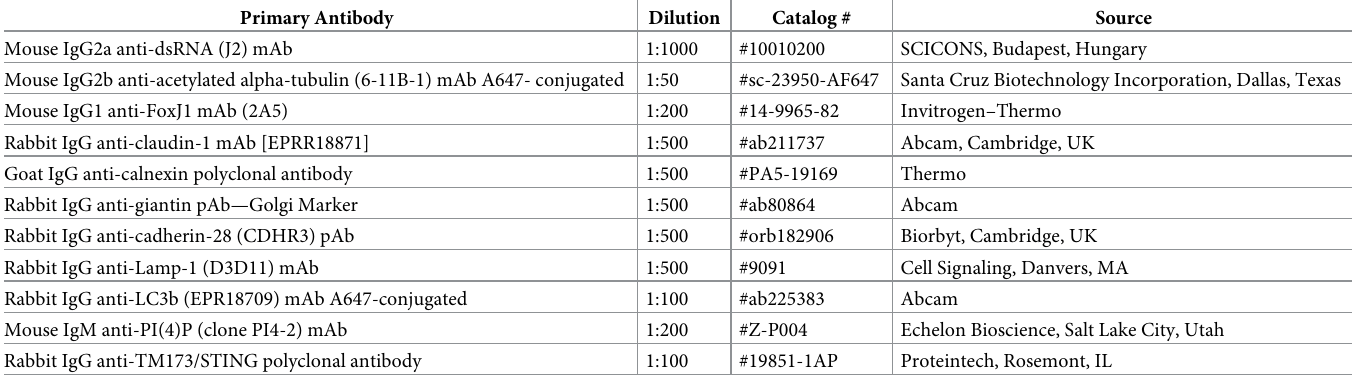
Table 1. Primary antibodies used in Immunofluorescence assays. Primary